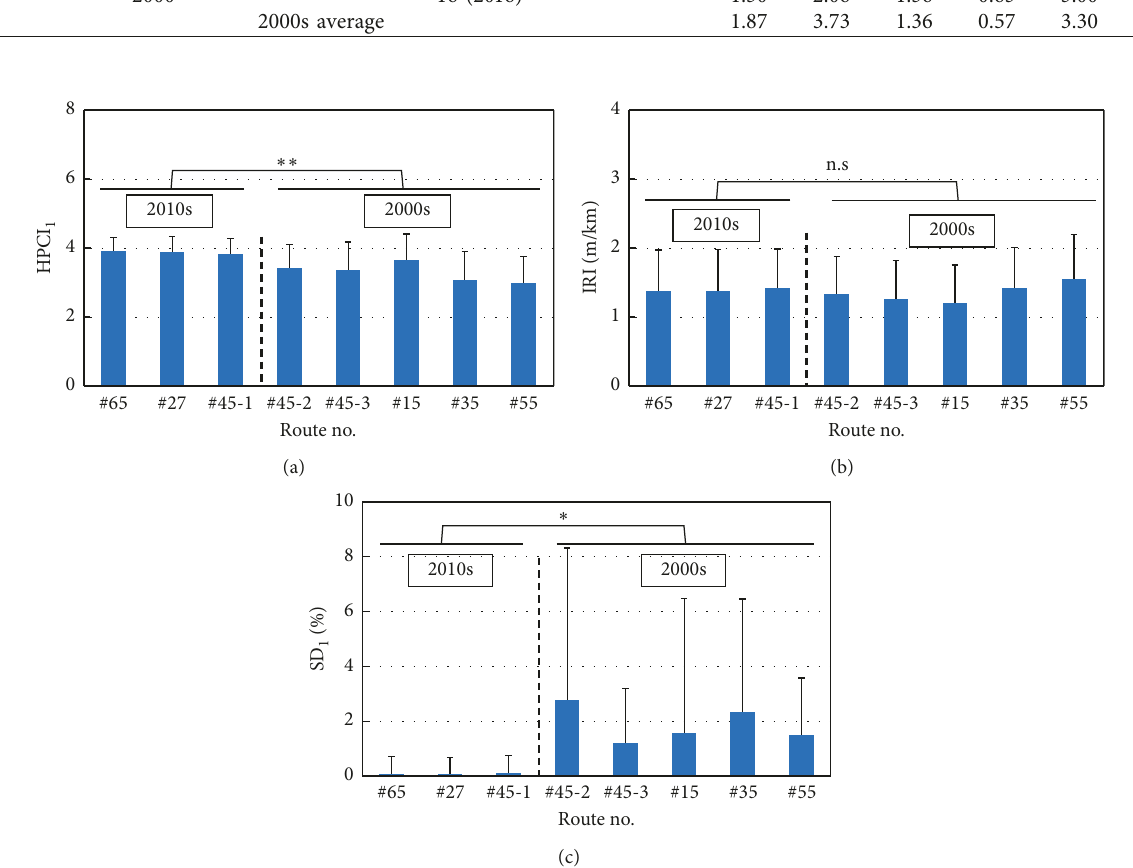
1 . (b) IRI (m/km). (c) SD 1